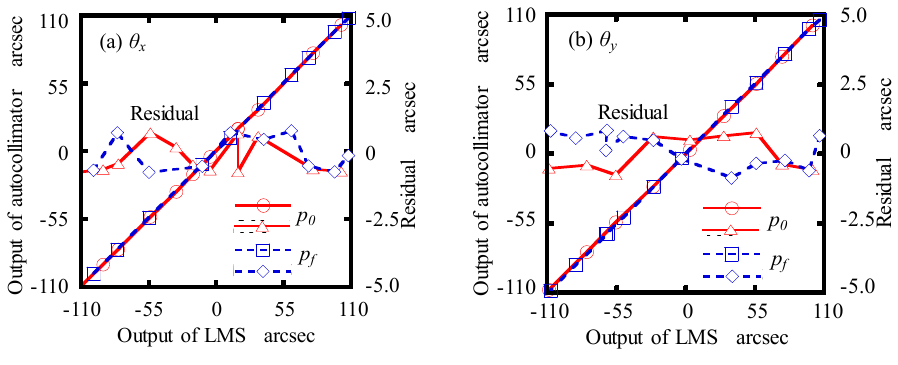
Figure 8. Calibration results of: ( a ) θ x ; ( b ) θ y .